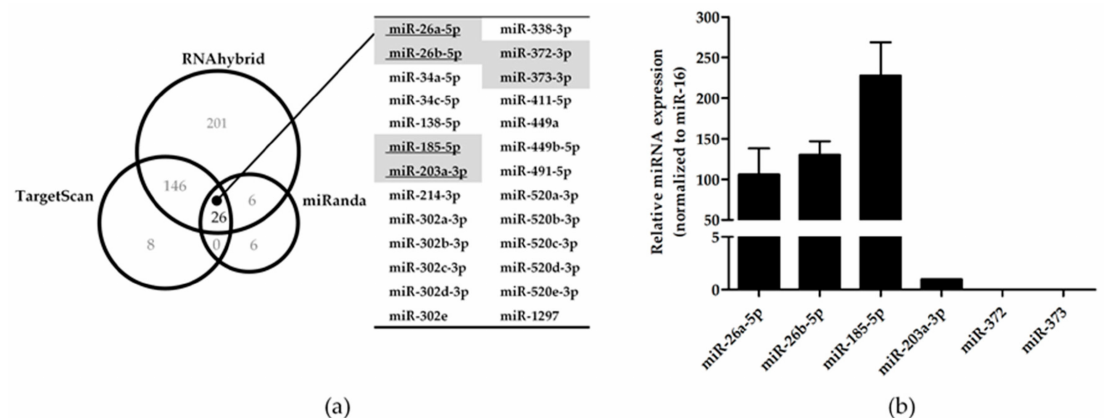
Figure 1. A summary of candidate miRNA prediction targets in KIR3DL3 and the endogenous expression of specific miRNAs. ( a ) Venn diagram representing the number of potential miRNAs for KIR3DL3 and the common miRNAs ( n = 26) predicted from three di ff erent miRNA-target prediction software (RNAhybrid, TargetScan and miRanda). The table highlights six miRNAs matched with previously identified miRNAs in human (CD56 + CD3 - ) NK cells [31]. Only four miRNA candidates were examined in the NK-92 cell line (underlined). ( b ) Endogenous expression of six miRNAs in NK-92 cells was determined by quantitative real-time polymerase chain reaction (qRT-PCR). The expression levels were normalized to miR-16. The results are depicted as mean ± standard error of mean